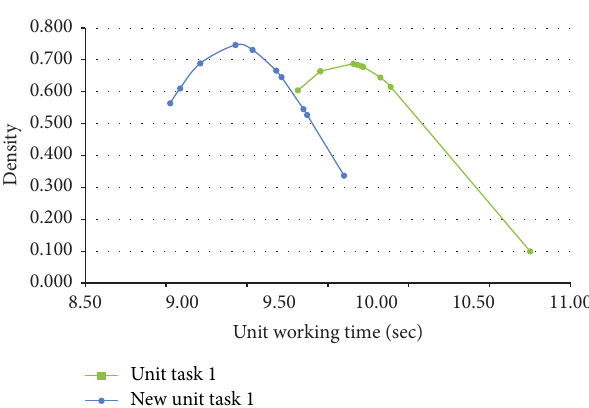
Figure 13: Working time distribution curve for unit task 1 of the assembly cell.